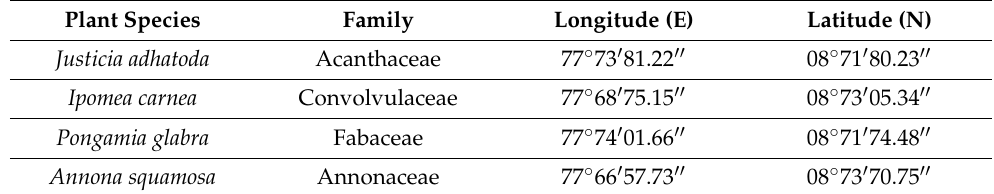
Table 1. Botanicals and their locations used in the current study. Plant Species